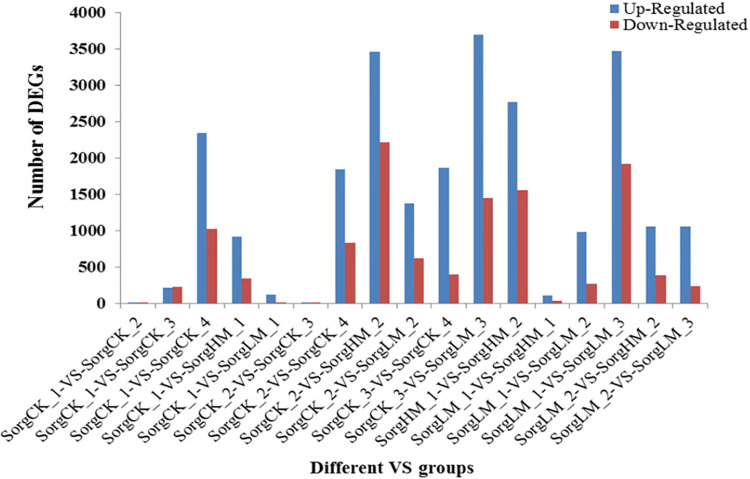
Number of differentially expressed genes (DEGs).X-axis represents different VS groups, and down-regulated and up-regulated DEGS were calculated. Y-axis represents the number of DEGS in each VS groups. SorgCK_1, SorgCK_2, SorgCK_3 and SorgCK_4 represented samples treated with 0 mmol/L MeJA at 19:00 (1h), 20:30 (2.5h), 22:30 (2.5h) and 0:30 (6.5h), respectively. SorgHM_1 and SorgHM_2 represented samples treated with 2.0 mmol/L MeJA at 19:00 (1h) and 20:30 (2.5h), respectively. SorgLM_1, SorgLM_2 and SorgLM_3 represented samples treated with 0.5 mmol/L MeJA at 19:00 (1h), 20:30 (2.5h) and 22:30 (4.5h), respectively.